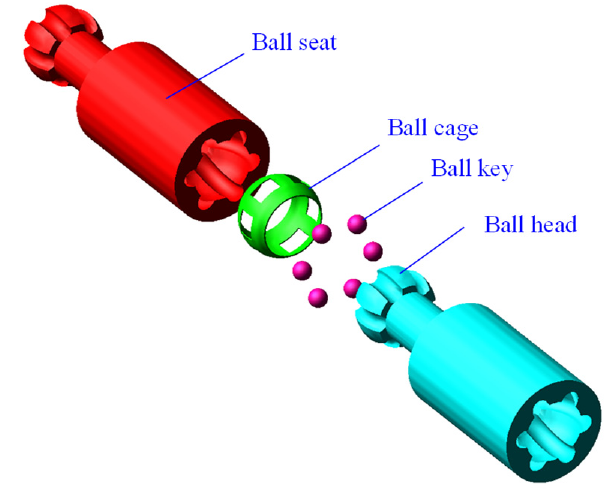
Figure 2. Schematic diagram of ball cage flexible joint.